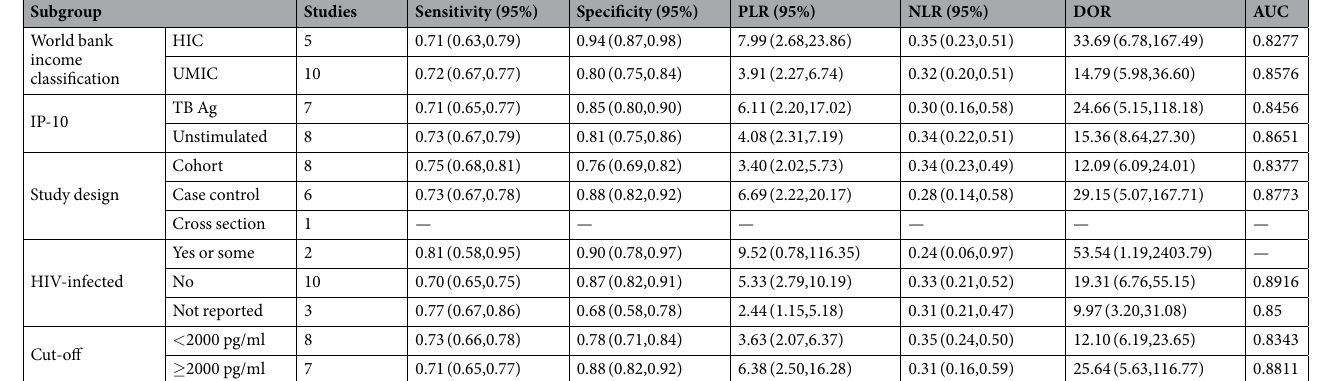
Table 3. Subgroup analysis of the included study. PLR: positive likelihood ratio, NLR: negative likelihood ratio, DOR: diagnostic odds ratio, AUC: area under the